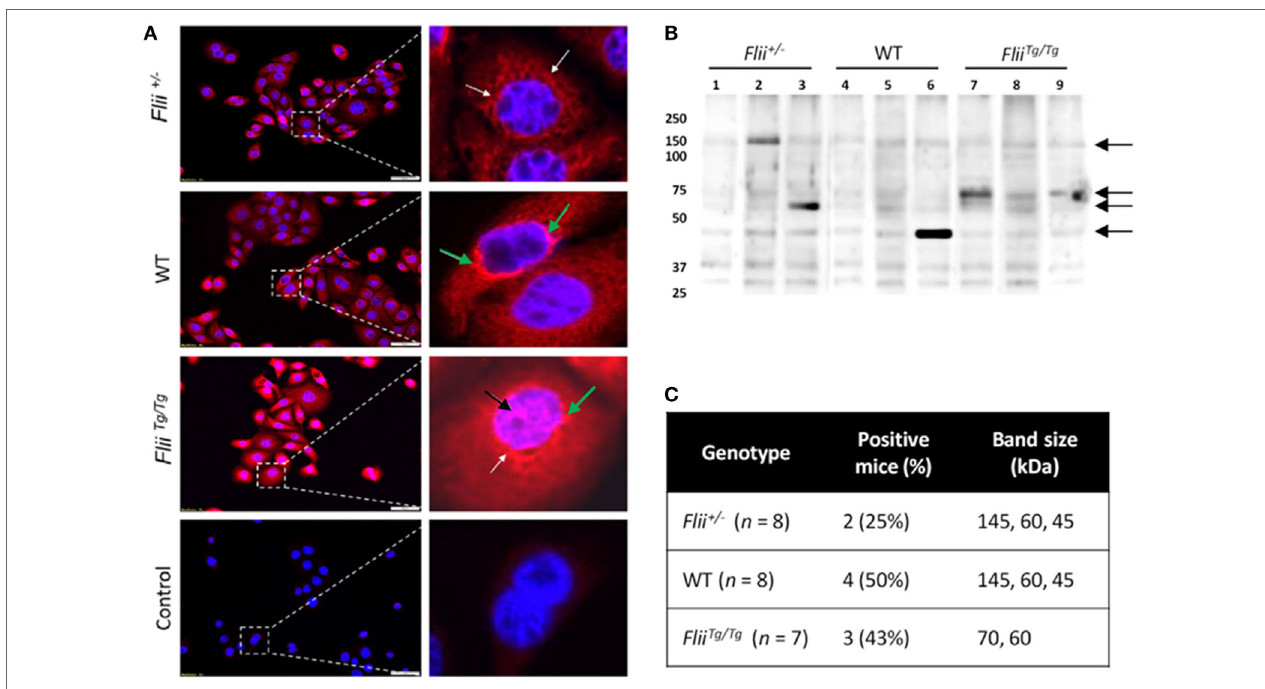
FigUre 6 | Over-expression of Flii produces an altered autoantibody profile in murine OVA-induced atopic dermatitis (AD) skin-like disease. (a) Representative images of IF microscopy staining patterns produced by mouse autoreactive IgG (red) and DAPI nuclear counterstaining (blue) in primary mouse keratinocytes. Magnification 20 × ; scale bar 50 µm. Antibodies from OVA-induced AD skin-like lesions of Flii + / − and WT mice producing a predominantly cytoplasmic (white arrow) and perinuclear (green arrow) staining patterns, while antibodies from OVA-induced AD skin-like lesions of Flii Tg/Tg mice produce a strong cytoplasmic, perinuclear (green arrow), and nuclear (black arrow) staining patterns. (B) Western blot analysis of murine keratinocyte proteins probed with pooled sera from OVA-induced AD-like mice (2–3 mice per lane); black arrows represent regions of autoreactivity. (c) Autoreactivity summary of Western blot results from murine keratinocyte lysate probed with sera from individual